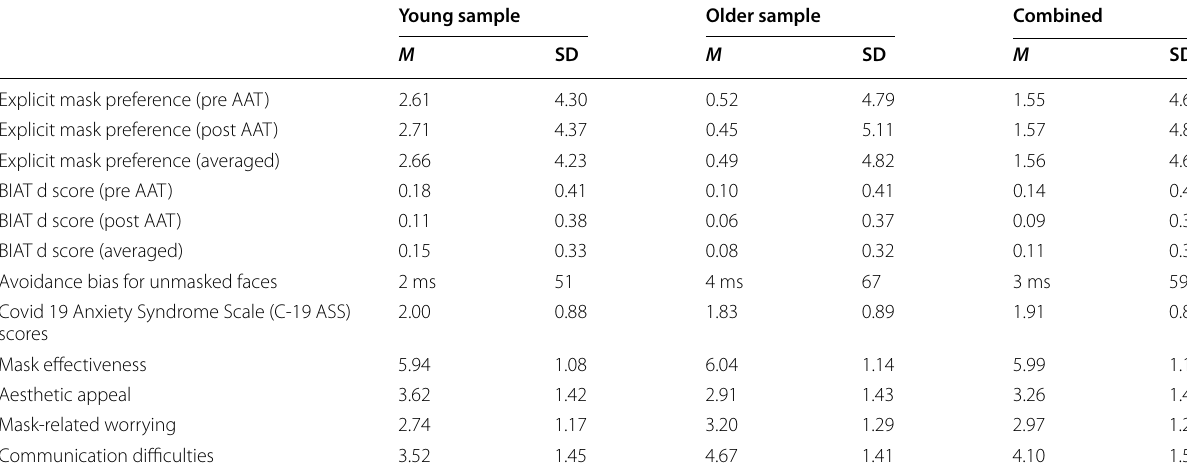
Explicit mask preference scores ranged from 6 to 6. Covid 19 Anxiety Syndrome Scale scores ranged from 0 to 4. Mask effectiveness, aesthetic appeal, mask-related − worrying, and communication difficulties scores ranged from 1 to 7